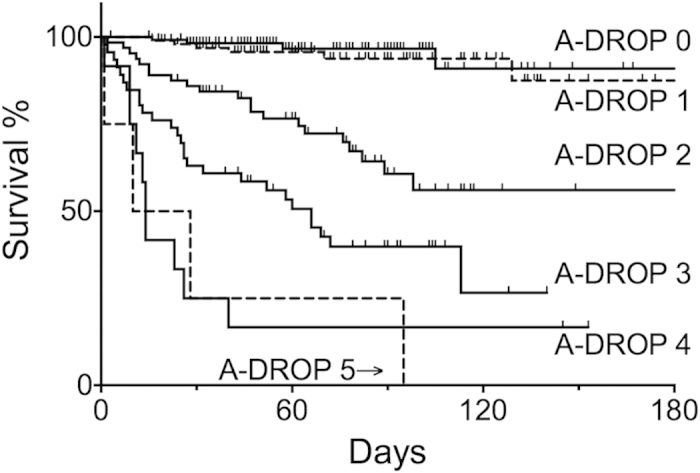
Kaplan-Meier curve for all-cause in-hospital death classified according to the total A-DROP score.Log-rank test: p < 0.001. The observation was not censored at 180th day. However, we presented the data until the 180th day because very limited number of cases were observed beyond the 180th day.